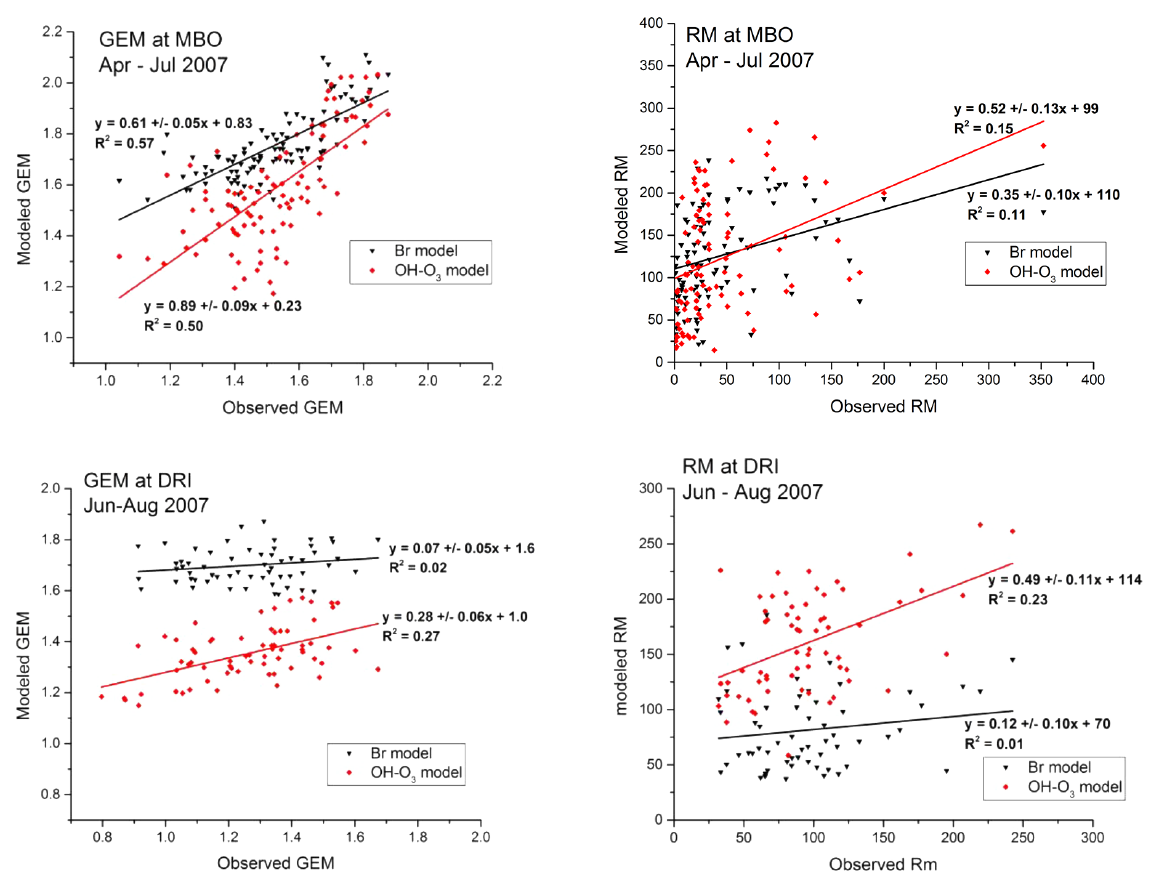
Figure 6. Comparison of linear relationships between GEM and RM in the observations with data from the model using either the Br or OH–O 3 oxidation